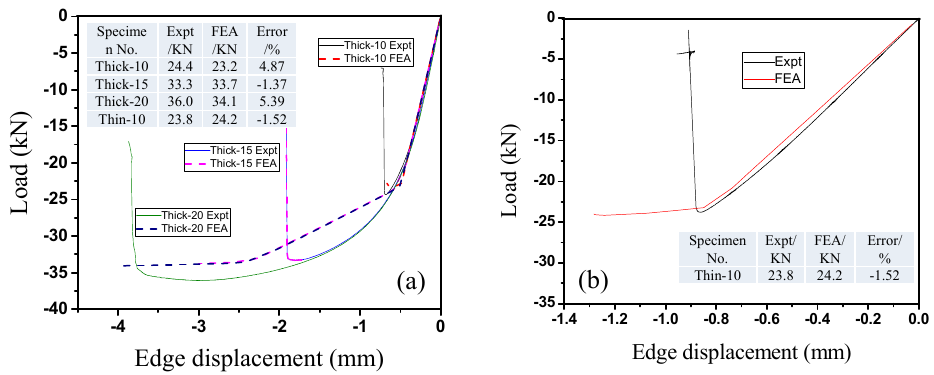
Figure 5. Load–displacement curves from lateral compressive tests and finite element simulations of the honeycomb panels: ( a ) thick test piece; ( b ) thin test piece.